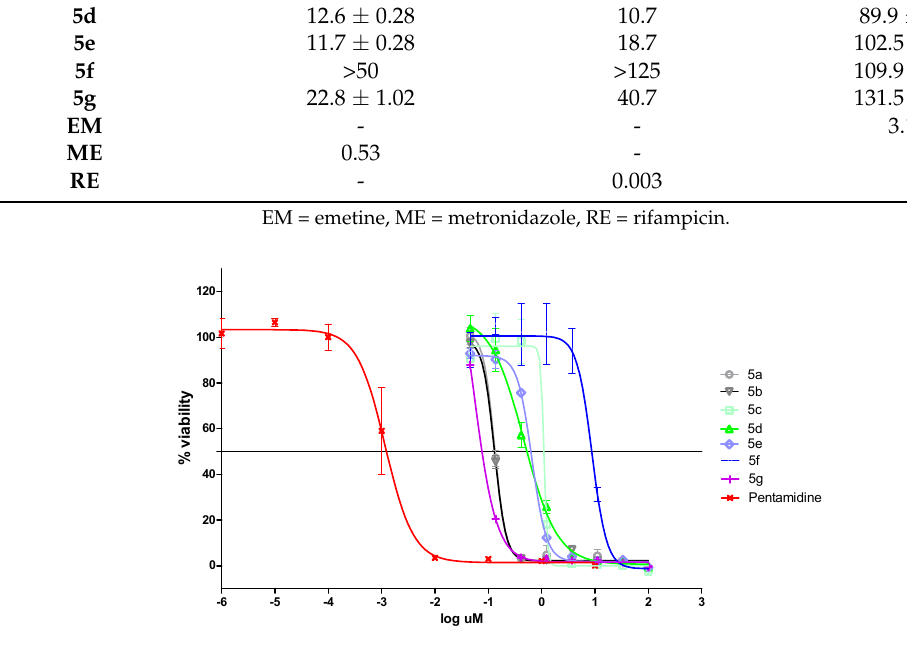
Figure 3. Percentage viability of the T. b. brucei parasites determined at different compound concentrations and corresponding IC 50 values of compounds 5a – g .